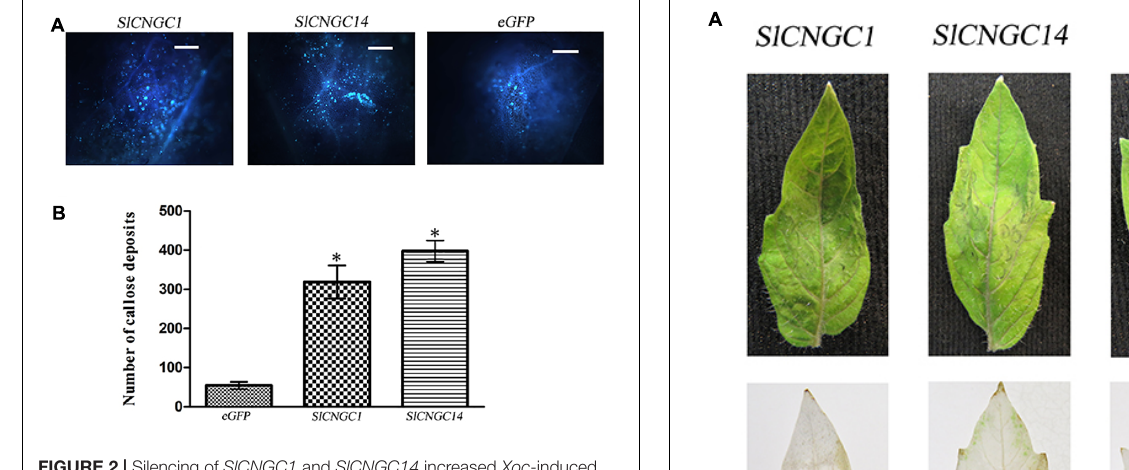
and SlCBP60g to different extent, which was much